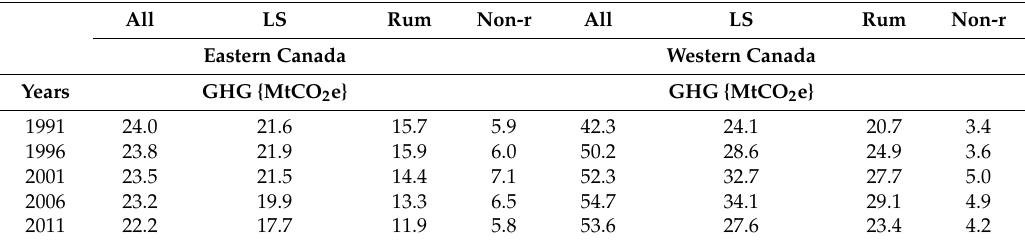
Table 5. GHG emissions from all farm types (All), all livestock (LS), ruminant livestock (Rum) and non-ruminant livestock (Non-r) in Eastern and Western Canada over census